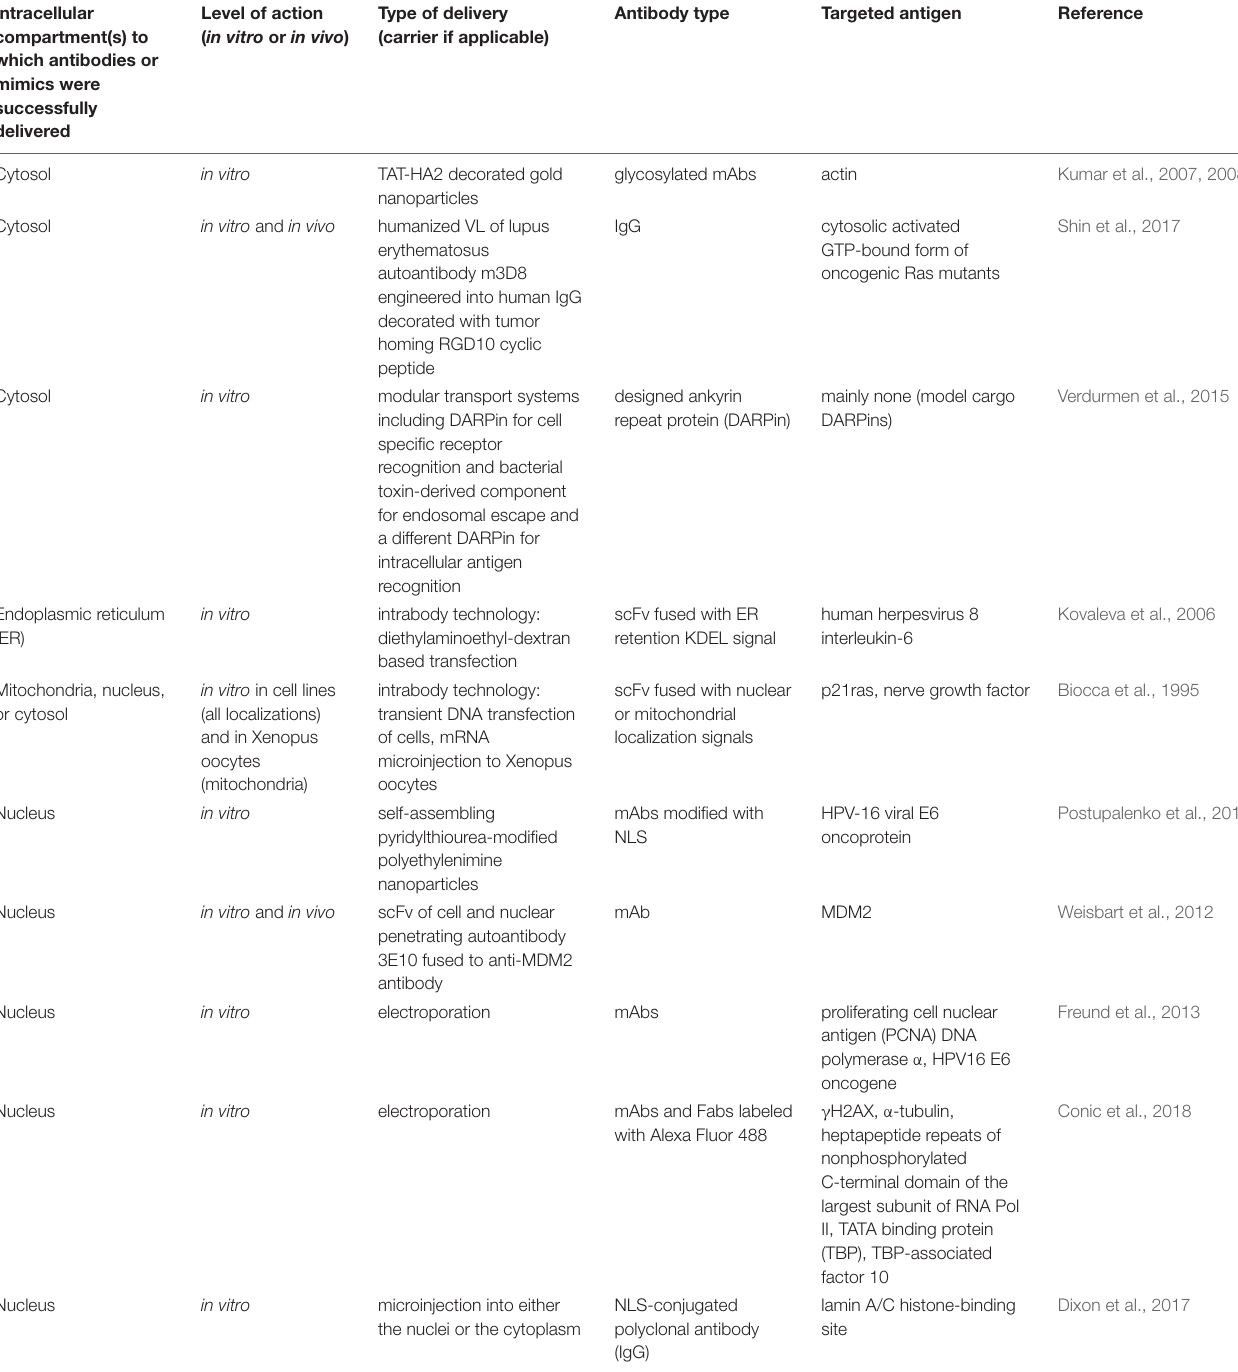
TABLE 4 | Examples of efficient intracellular delivery of antibodies aimed at various intracellular compartments. Intracellular compartment(s) to which antibodies or mimics were successfully